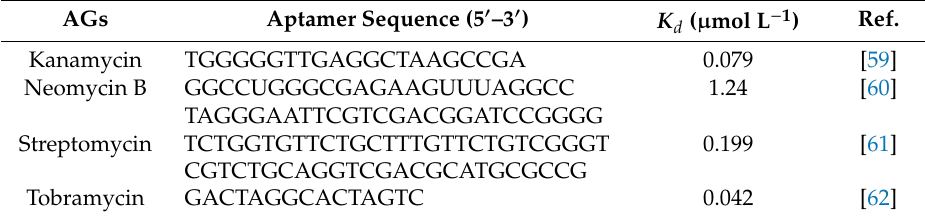
Table 2. Specific aptamer sequences of several AGs.